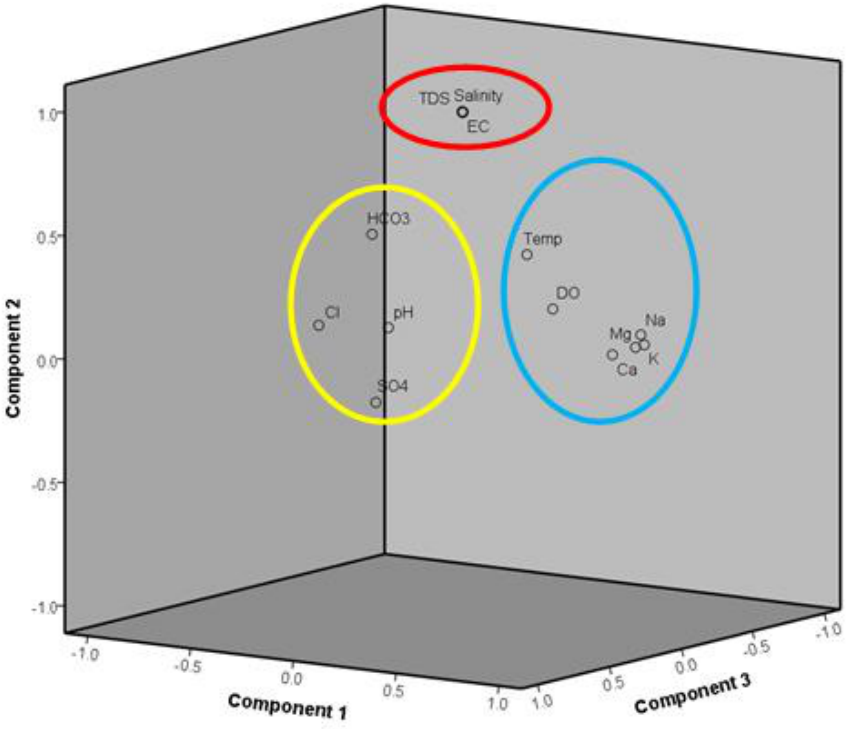
Figure 5. Rotated component of PCA . Table 7. Principal component loading of the measured variables.